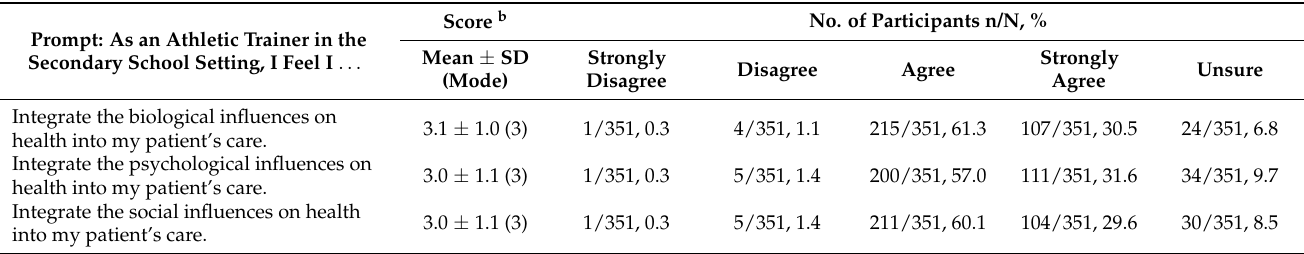
Table 4. Biopsychosocial Model of Health Tool Items and Responses a